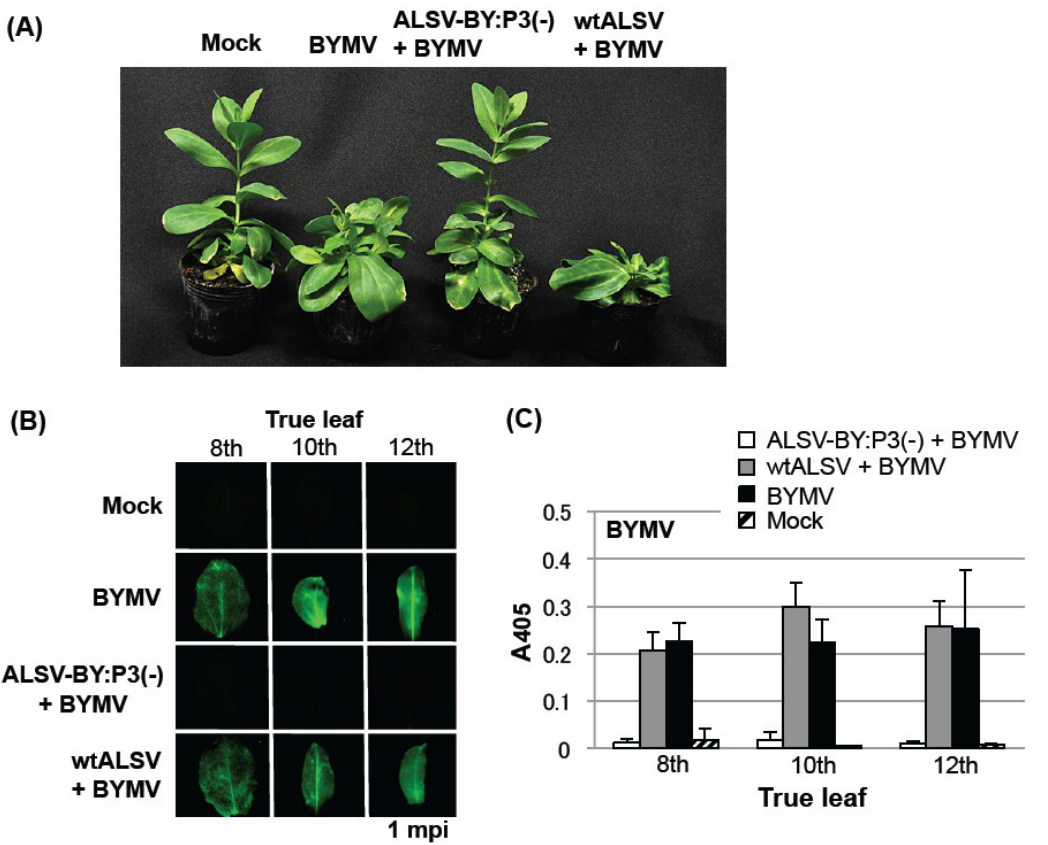
Figure 4. Preventive effect of pre-inoculating eustoma plants with an Apple latent spherical virus (ALSV) vaccine (ALSV-BY:P3(−)) on challenge inoculation with a Bean yellow mosaic virus (BYMV) expressing green fluorescent protein. ( A ) Symptoms of eustoma plants inoculated with BYMV only, co-inoculated with ALSV vaccine and BYMV, or co-inoculated with wtALSV and BYMV, at two months post-inoculation (mpi); ( B ) Fluorescence microscopy of the eighth to 12th true leaves of inoculated eustoma plants at 1 mpi; ( C ) Enzyme-linked immunosorbent assay (ELISA) measuring the accumulation of BYMV in the sixth to 12th leaves of the eustoma plants shown in ( B ). In both the ALSV vaccine + BYMV and wtALSV + BYMV groups, ELISA values of ALSV in the eighth to 12th leaves were 1.0 to